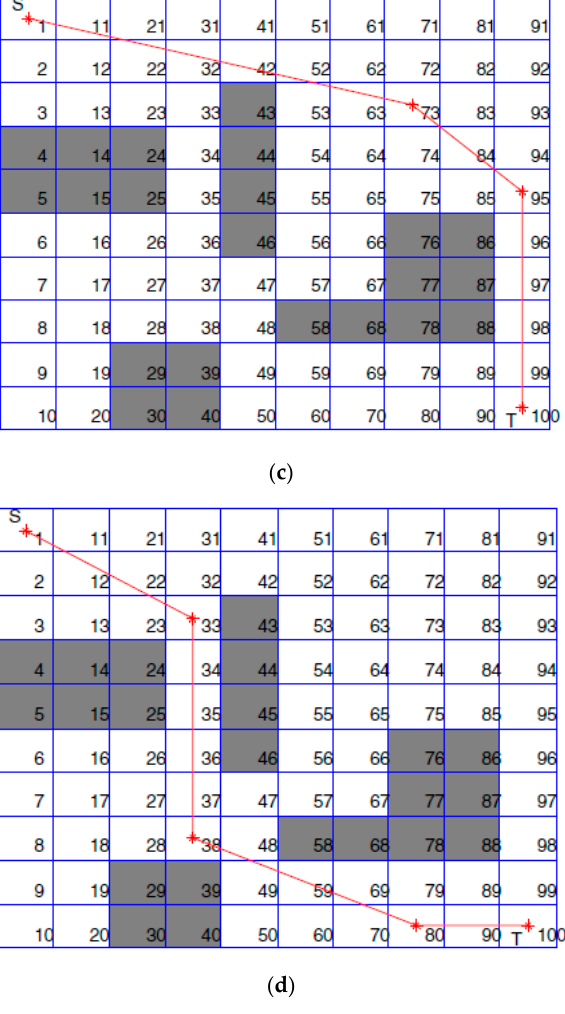
Figure 17. The best path achieved by ( a ) AACO, ( b ) GA [31], ( c ) PS [31], and ( d ) PSO [31] (Map 2). Table 7. Performance comparison of the proposed AACO and the algorithms of Reference [31].